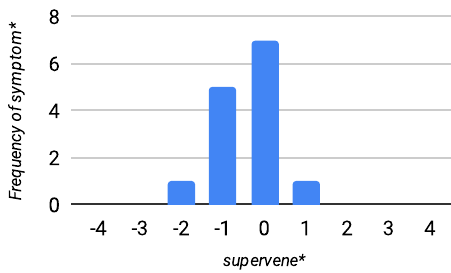
Fig. 3 Distribution of lemma of SYMPTOM with respect to conjugations of verb at node = 0. Verb supervene with symptom in English core corpus, standard deviation from mean, μ = − 0.86, σ = 0.90. Starred items denote noun and verb forms rather than tokens.